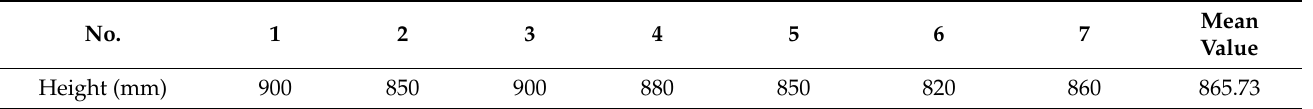
The camera’s visual field is the o peration region in front of the harvester reel. The